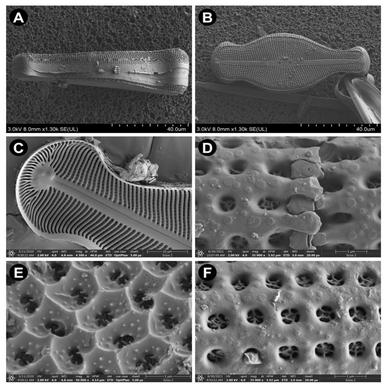
SEM images of diatom frustule (Didymosphenia geminata – DG; Aulacoseira sp. – AU) and their characteristic features: (A) girdle band view (DG); (B) valve view (DG); (C) view of the internal of the frustule – ribs (DG); (D) magnification of the connection between frustules (AU) (E) magnification of the external valve surface – openings (areaolas) (DG), openings with glazing bars (AU).